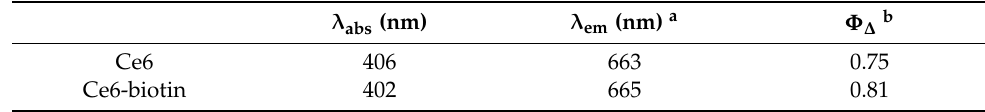
Table 1. Photochemical data for Ce6 and Ce6-biotin.